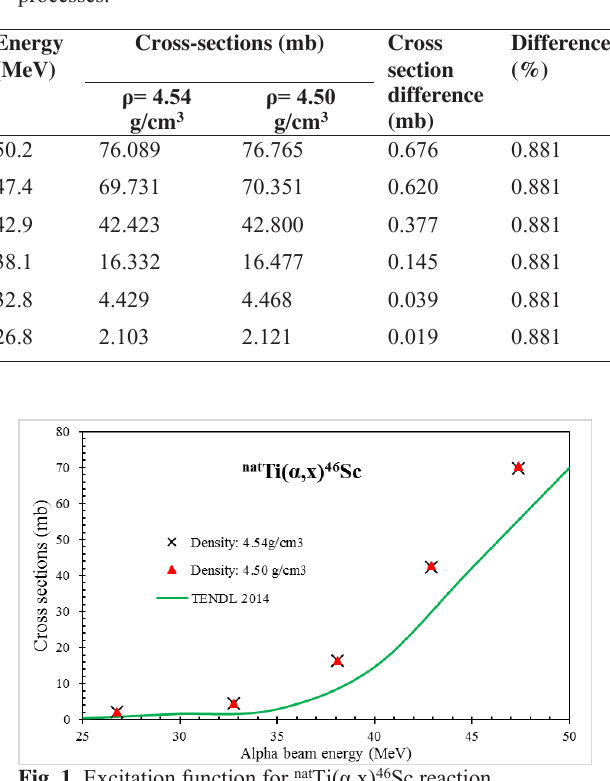
Table 2. Measured cross-sections for nat Ti(α,x) 46 Sc nuclear processes.